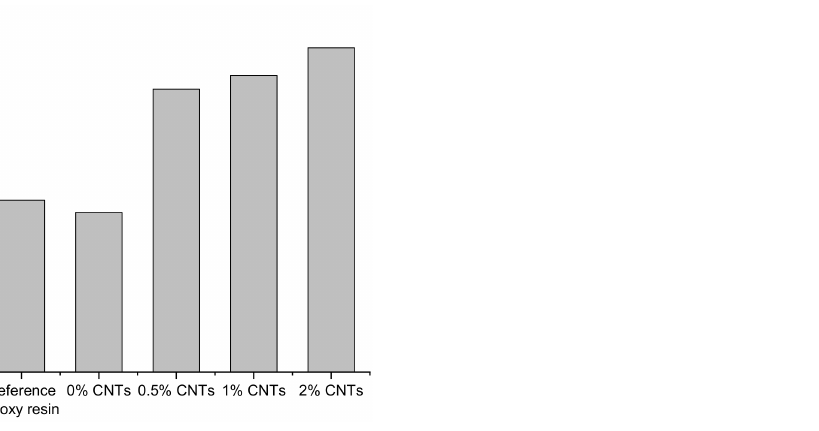
Figure 9. Comparison of the production cost of the adhesive joints bonded with the neat, the nano-filled and the reference epoxy